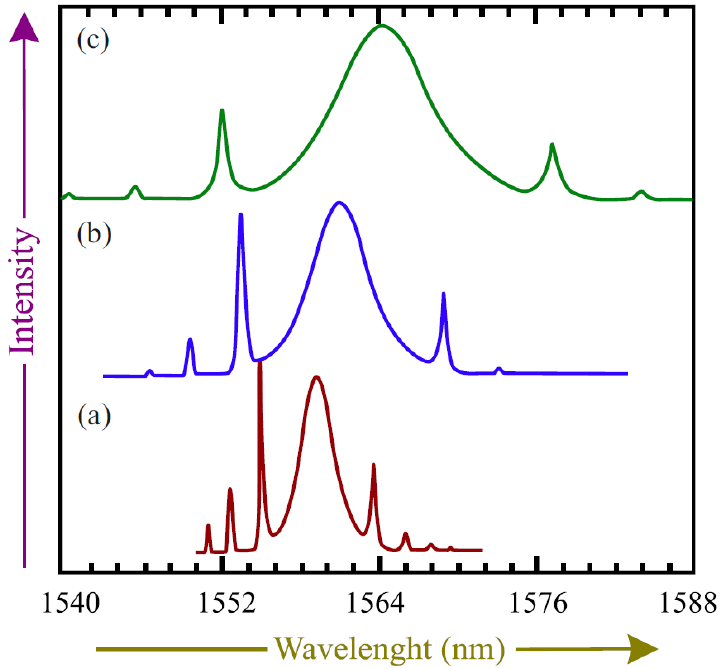
Figure 5. Optical spectral envelopes obtained in lasers with different cavity lengths. Pulse duration and total dispersion for: (a) 1130 fs, 616 fs/nm; (b) 470 fs, 216 fs/nm; (c) 300 fs, 79 fs/nm. Dispersion waves propagate following the linear dispersion coefficient β D , while the soliton following the nonlinear dispersion coefficient, which considers the influence of the SPM on the β S pulse [97]. Each time a soliton passes through the cavity, it generates dispersive waves that interfere with each other. The growth of the dispersion wave ampli- tude depends on the phase, each new phase formed during the passage of the dispersive wave. As a result, the strongest dispersive waves are generated when its phase becomes a multiple of the 2 π phase of the soliton (i.e., each new dispersive wave is in phase with the one already propagating in the resonator). Mathematically, it looks like this [98]: